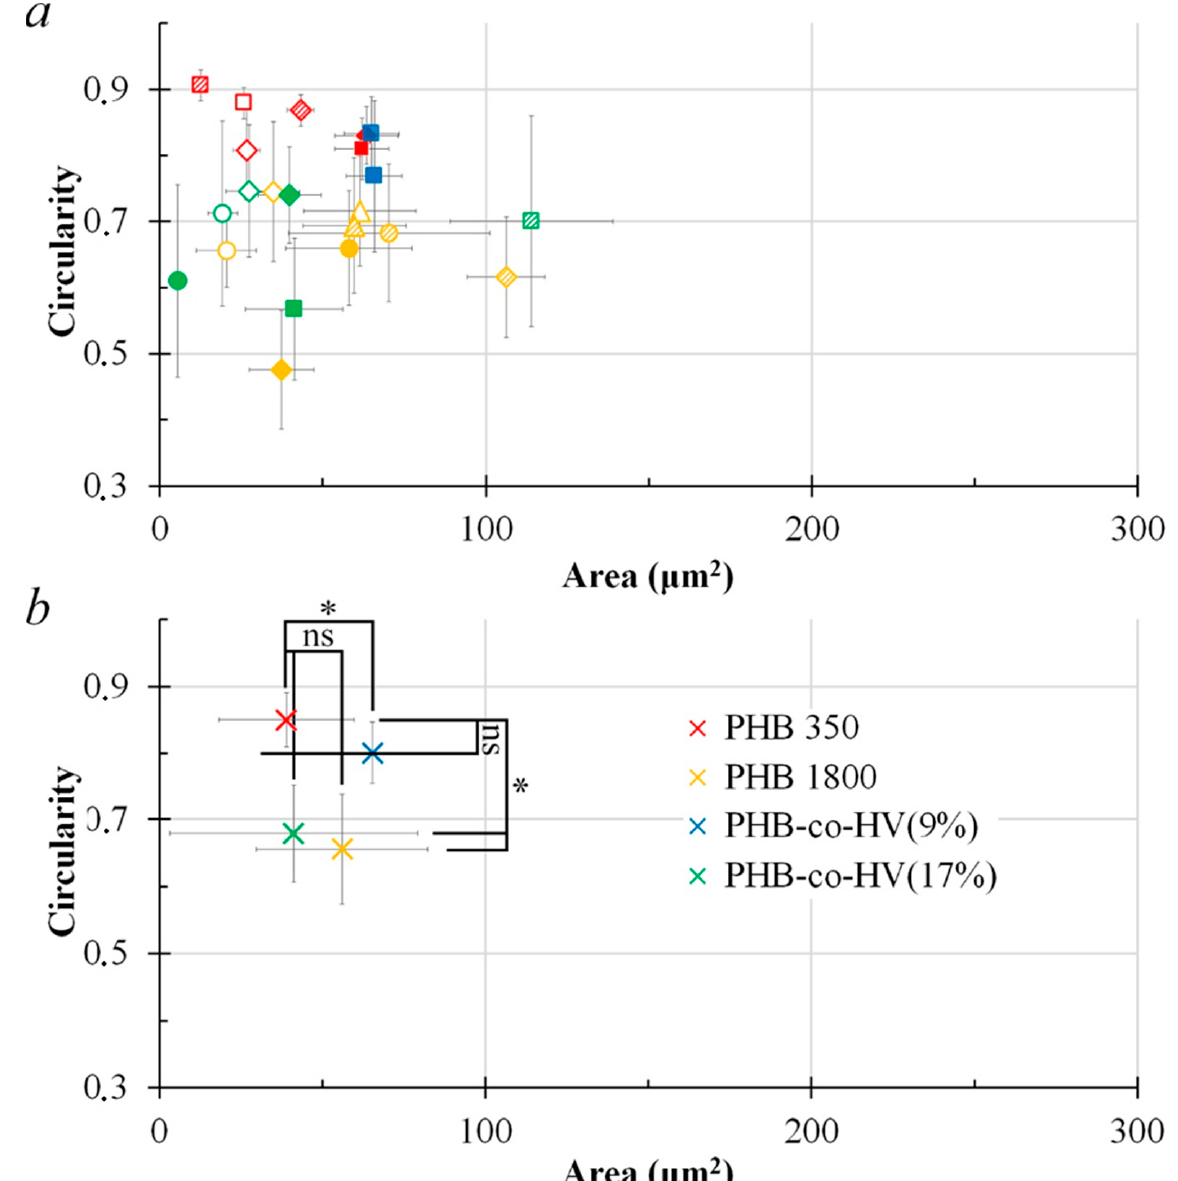
Figure 7. Area vs. circularity plot of structural elements based on their respective concentrations and volumes (150 μ L, 300 μ L, 450 μ L) with the distance L = 1 cm (n = 13). Legends: Polymers: red—PHB 350 kDa; yellow—PHB 1800 kDa; blue—PHB- co -HV (9%); green—PHB- co -HV(17%). Concentration: ◯ —5 mg/mL; △ —10 mg/mL; ◇ —20 mg/mL; □ —40 mg/mL. Volume: blank marker—150 μ L; shaded marker—300 μ L; filled marker—450 μ L ( a ). Average data for each polymer group PHB350, PHB1800, PHB- co -HV(9%), PHB- co -HV(17%), n = number of data points for each polymer type; * ( p < 0.05 vs. PHB350) or ns ( p > 0.05 vs. PHB350) for polymer groups representing area and circularity, the Kruskal–Wallis one-way ANOVA test for more than 2 independent groups ( b ).